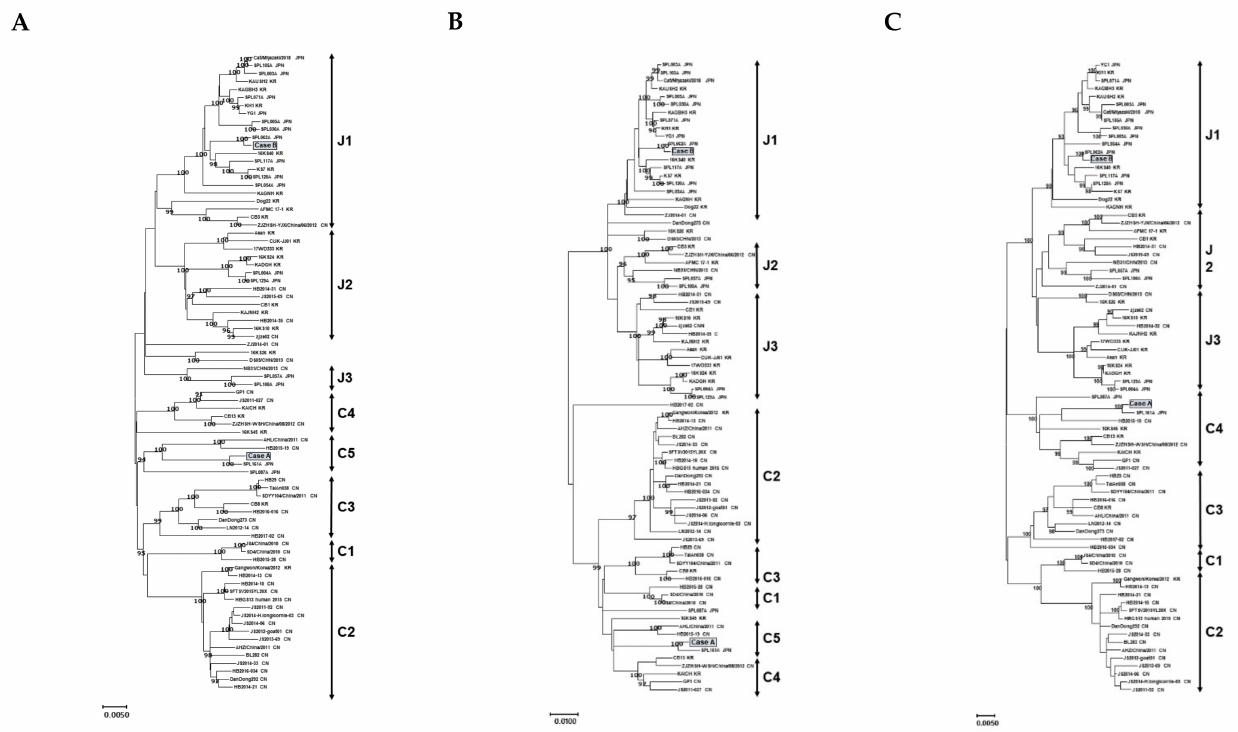
Figure 1. Phylogenetic classification of the SFTSV. The maximum likelihood tree was constructed with the near-full-length genome sequences (about 10.0 kb) obtained from the specimens collected in Osaka in 2017 and 2018 in this study ( n = 2), SFTSV reference sequences from past epidemics in Japan and other countries ( n = 78). The phylogenetic trees are shown as segment L ( A ), segment M ( B ), and segment S ( C ). The bootstrap value is shown to be above